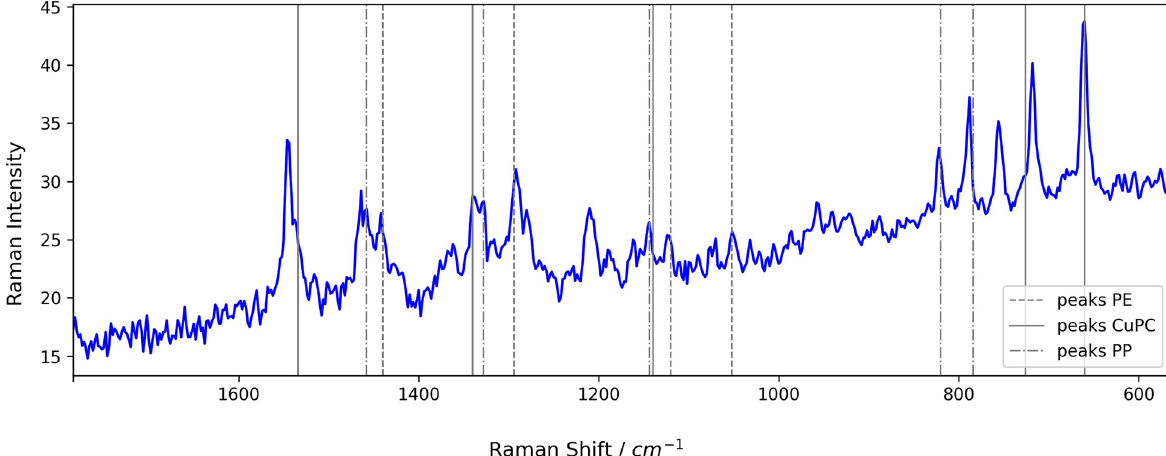
Fig. 7 Spectrum containing peaks from PE, PP, and the pigment copper phthalocyanine